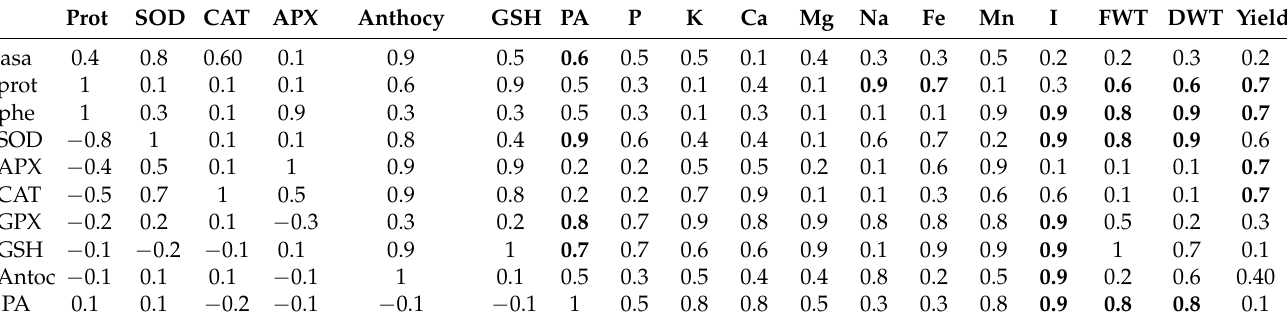
Table 9. Comparation between traits using multiple linear regression and Pearson coefficients.